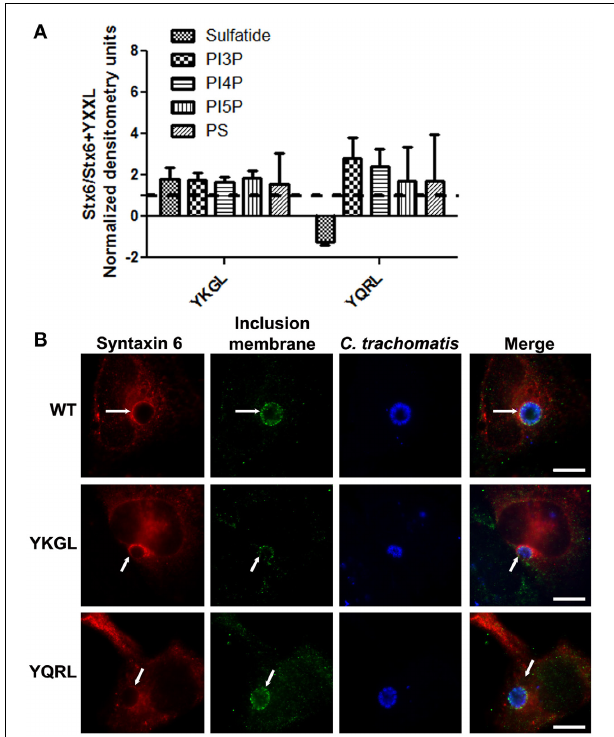
FIGURE 7 | Syntaxin 6 + YKGL or + YQRL protein-lipid interactions and localization to the chlamydial inclusion. In (A) , 3XFLAG-syntaxin 6 wild-type (WT), 3XFLAG-syntaxin 6 + YKGL (YKGL), and 3XFLAG-syntaxin 6 +YQRL (YQRL) were immunoprecipitated from HeLa cells and incubated with Sphingostrips or PIPstrips. Fold increase in syntaxin 6-lipid binding was determined by normalization of densitometry to input. Graph depicts the fold changes in densitometry levels of WT compared to YKGL or YQRL, respectively. The graph combines three independent Sphingostrip and PIPstrip assays. Averages and standard error of the mean are shown. In (B) , HeLa cells were transfected with WT, YKGL, or YQRL constructs, infected and fixed in ethanol as described in Figure 3 . The samples were processed for indirect immunofluorescence to detect the 3XFLAG (red), the inclusion membrane (green), or organisms (blue). Images are representative of two independent experiments. White arrows indicate colocalization with the inclusion; bars, 10 μ